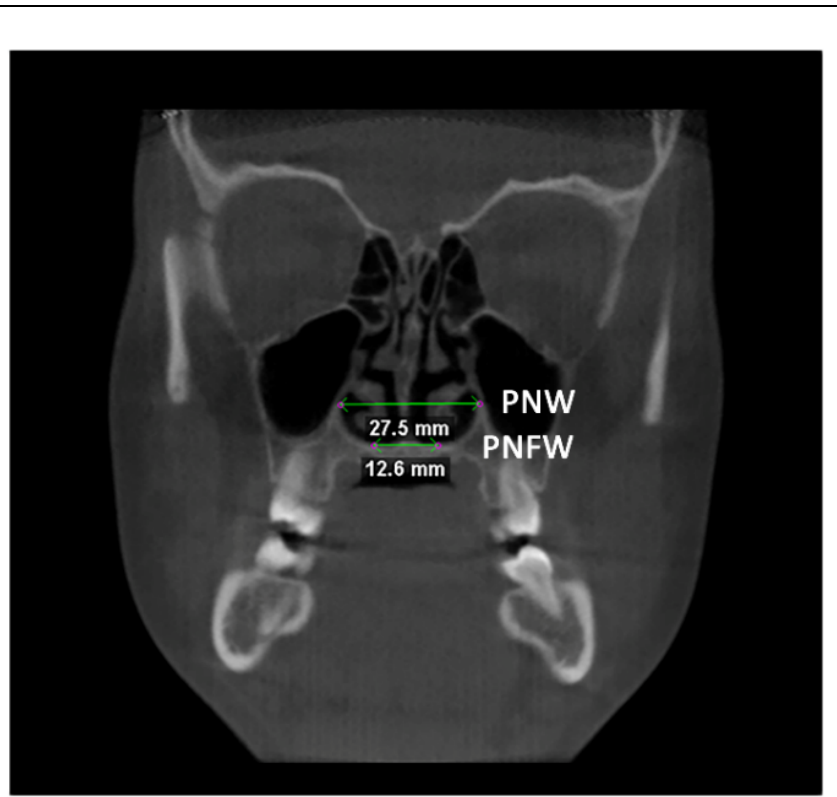
Figure 3. Linear measurements of anterior nasal width (ANW) and anterior nasal floor width (ANFW) in the coronal plane.